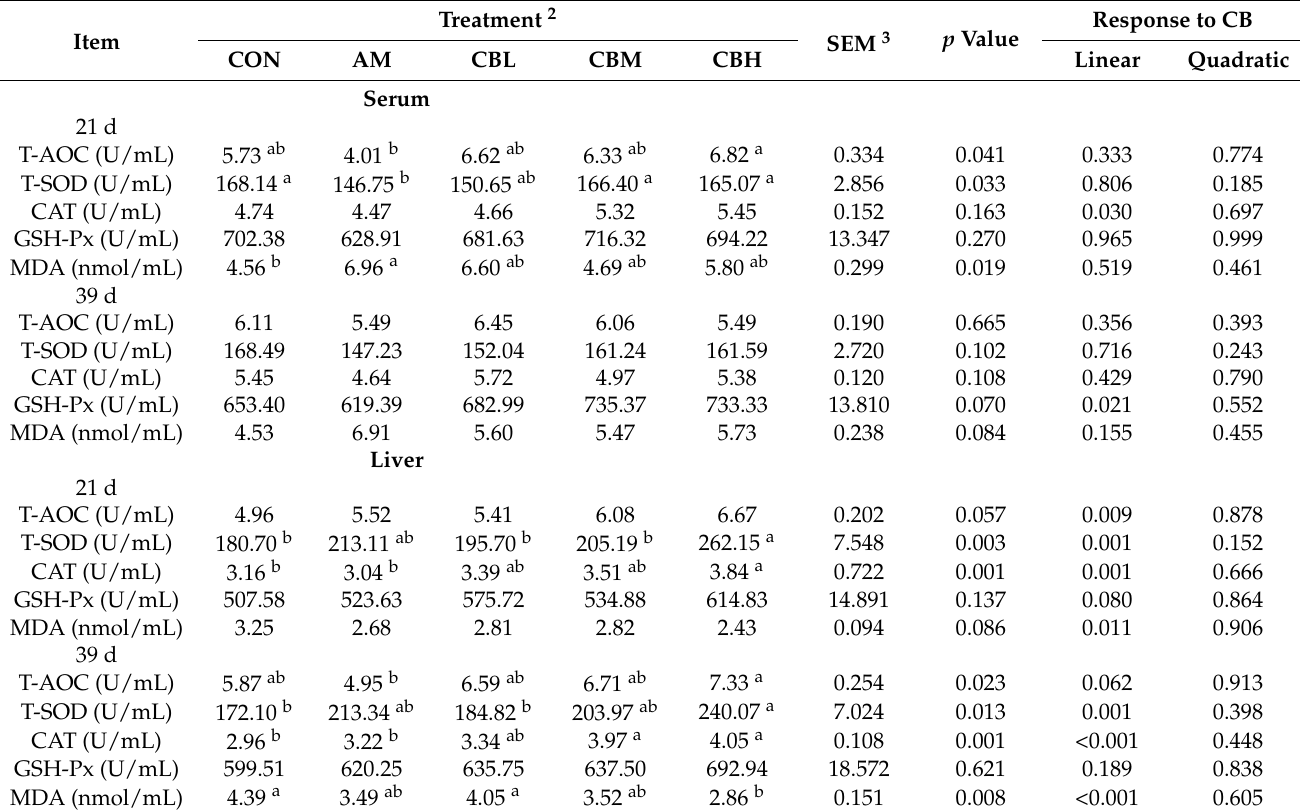
Table 3. Effects of C. butyricum on serum and liver antioxidant capacity of broilers 1